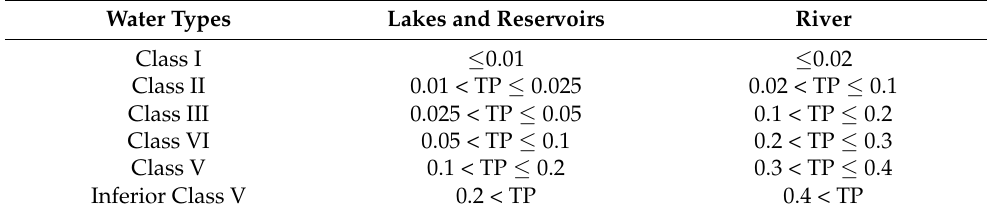
Table 1. The classification thresholds of six water types according to TP. Water Types Lakes and